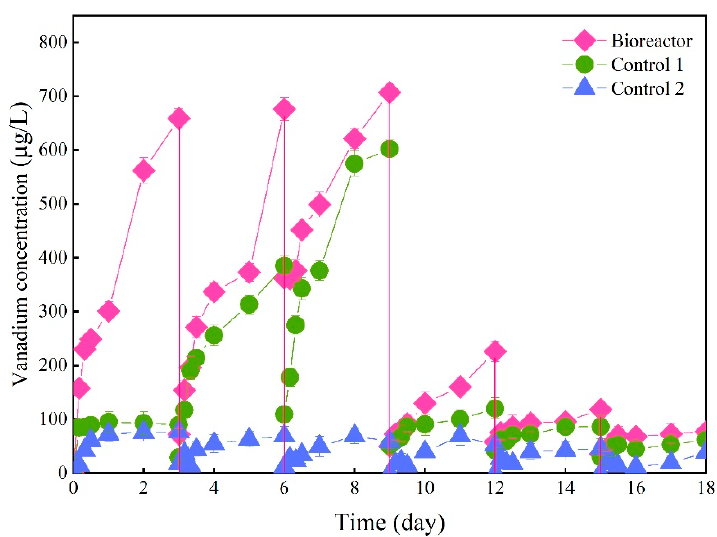
Figure 2. Variations of leached vanadium concentrations during six consecutive operating cycles.